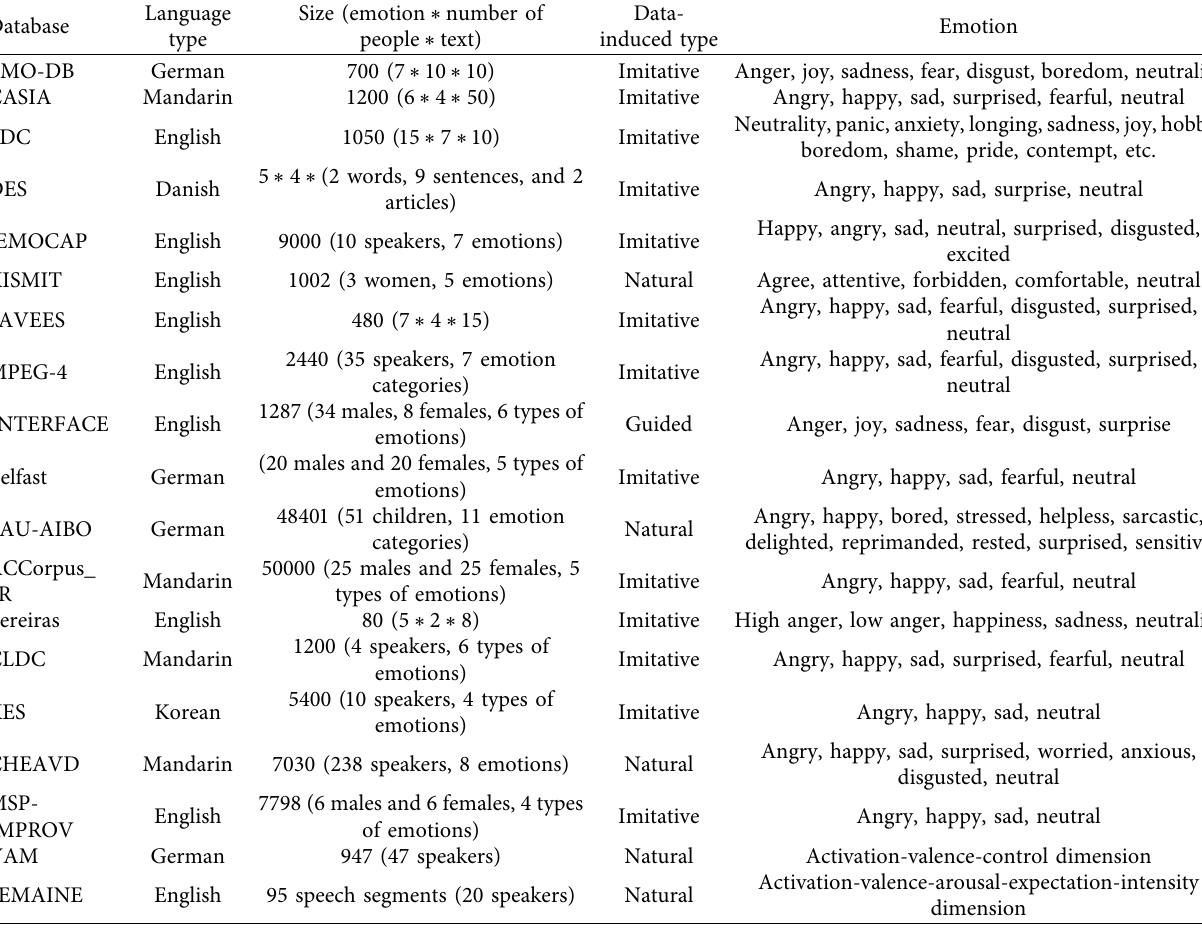
Table 3: Common speech